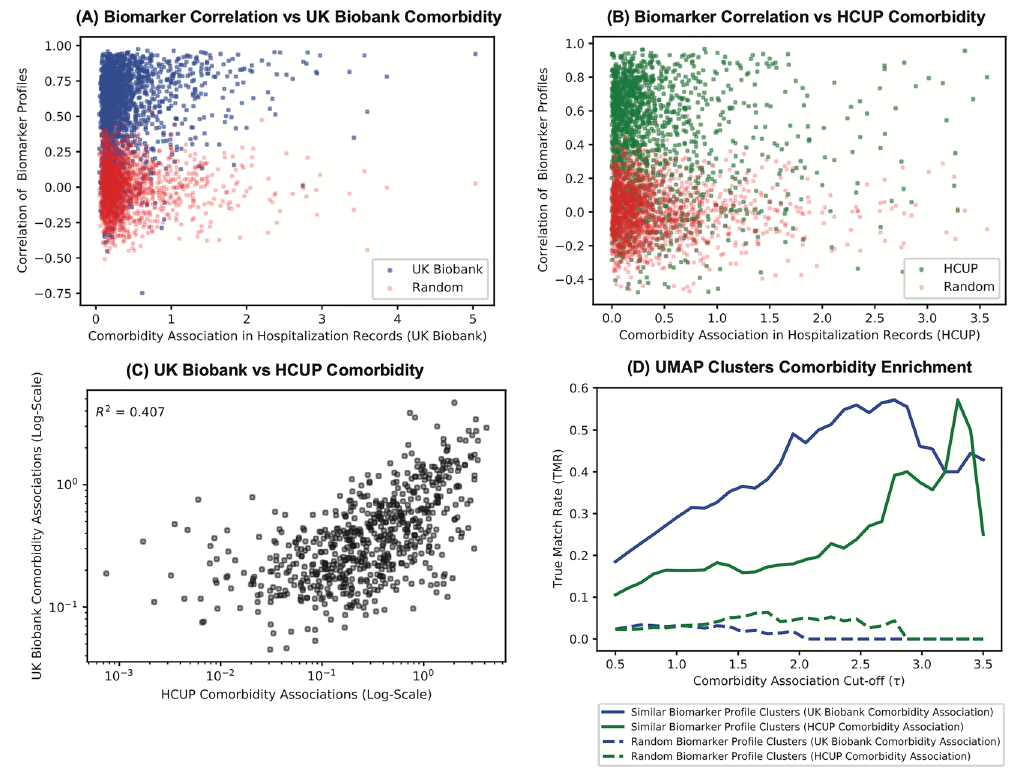
Figure 6. Relationship between biomarker similarity-based clusters and disease comorbidity in HCUP and UK Biobank. Diseases with similar biomarker hazard profiles are more likely to co-occur than at random. Each scatter point in sub-figures a,b,c are unique disease pairs ( A ) Comorbidity association in UK Biobank vs. biomarker profile similarity in UK Biobank ( B ) Comorbidity association in HCUP vs. biomarker profile similarity in UK Biobank ( C ) Comorbidity association in UK Biobank vs HCUP. ( D ) Cluster True Match Rate (TMR) as a function of comorbidity association in UK Biobank, HCUP and random.